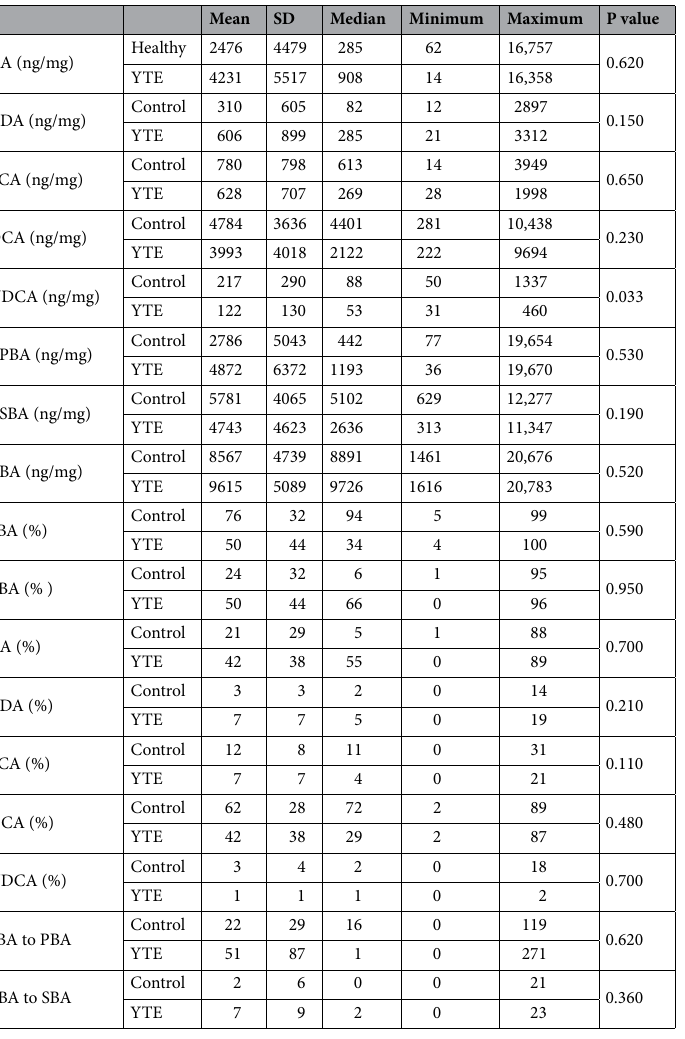
Table 2. Summary statistics of fecal bile acid concentrations in healthy and YTE dogs. CA, cholic acid; CDCA, chenodeoxycholic acid; LCA, lithocholic acid; DCA, deoxycholic acid; UDCA, ursodeoxycholic acid; TPBA, total primary bile acids; TSBA, total secondary bile acids; SBA to PBA; ratio of secondary to primary bile acids; PBA to SBA, ratio of primary to secondary bile acids; YTE, Yorkshire Terrier enteropathy; SD, standard